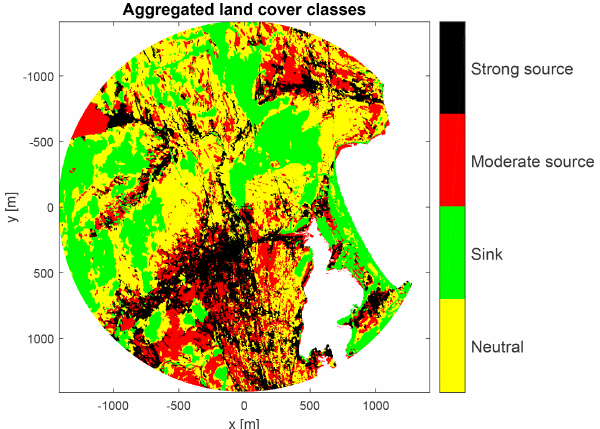
Figure 2. Distribution of the aggregated land cover classes (exclud- ing marine